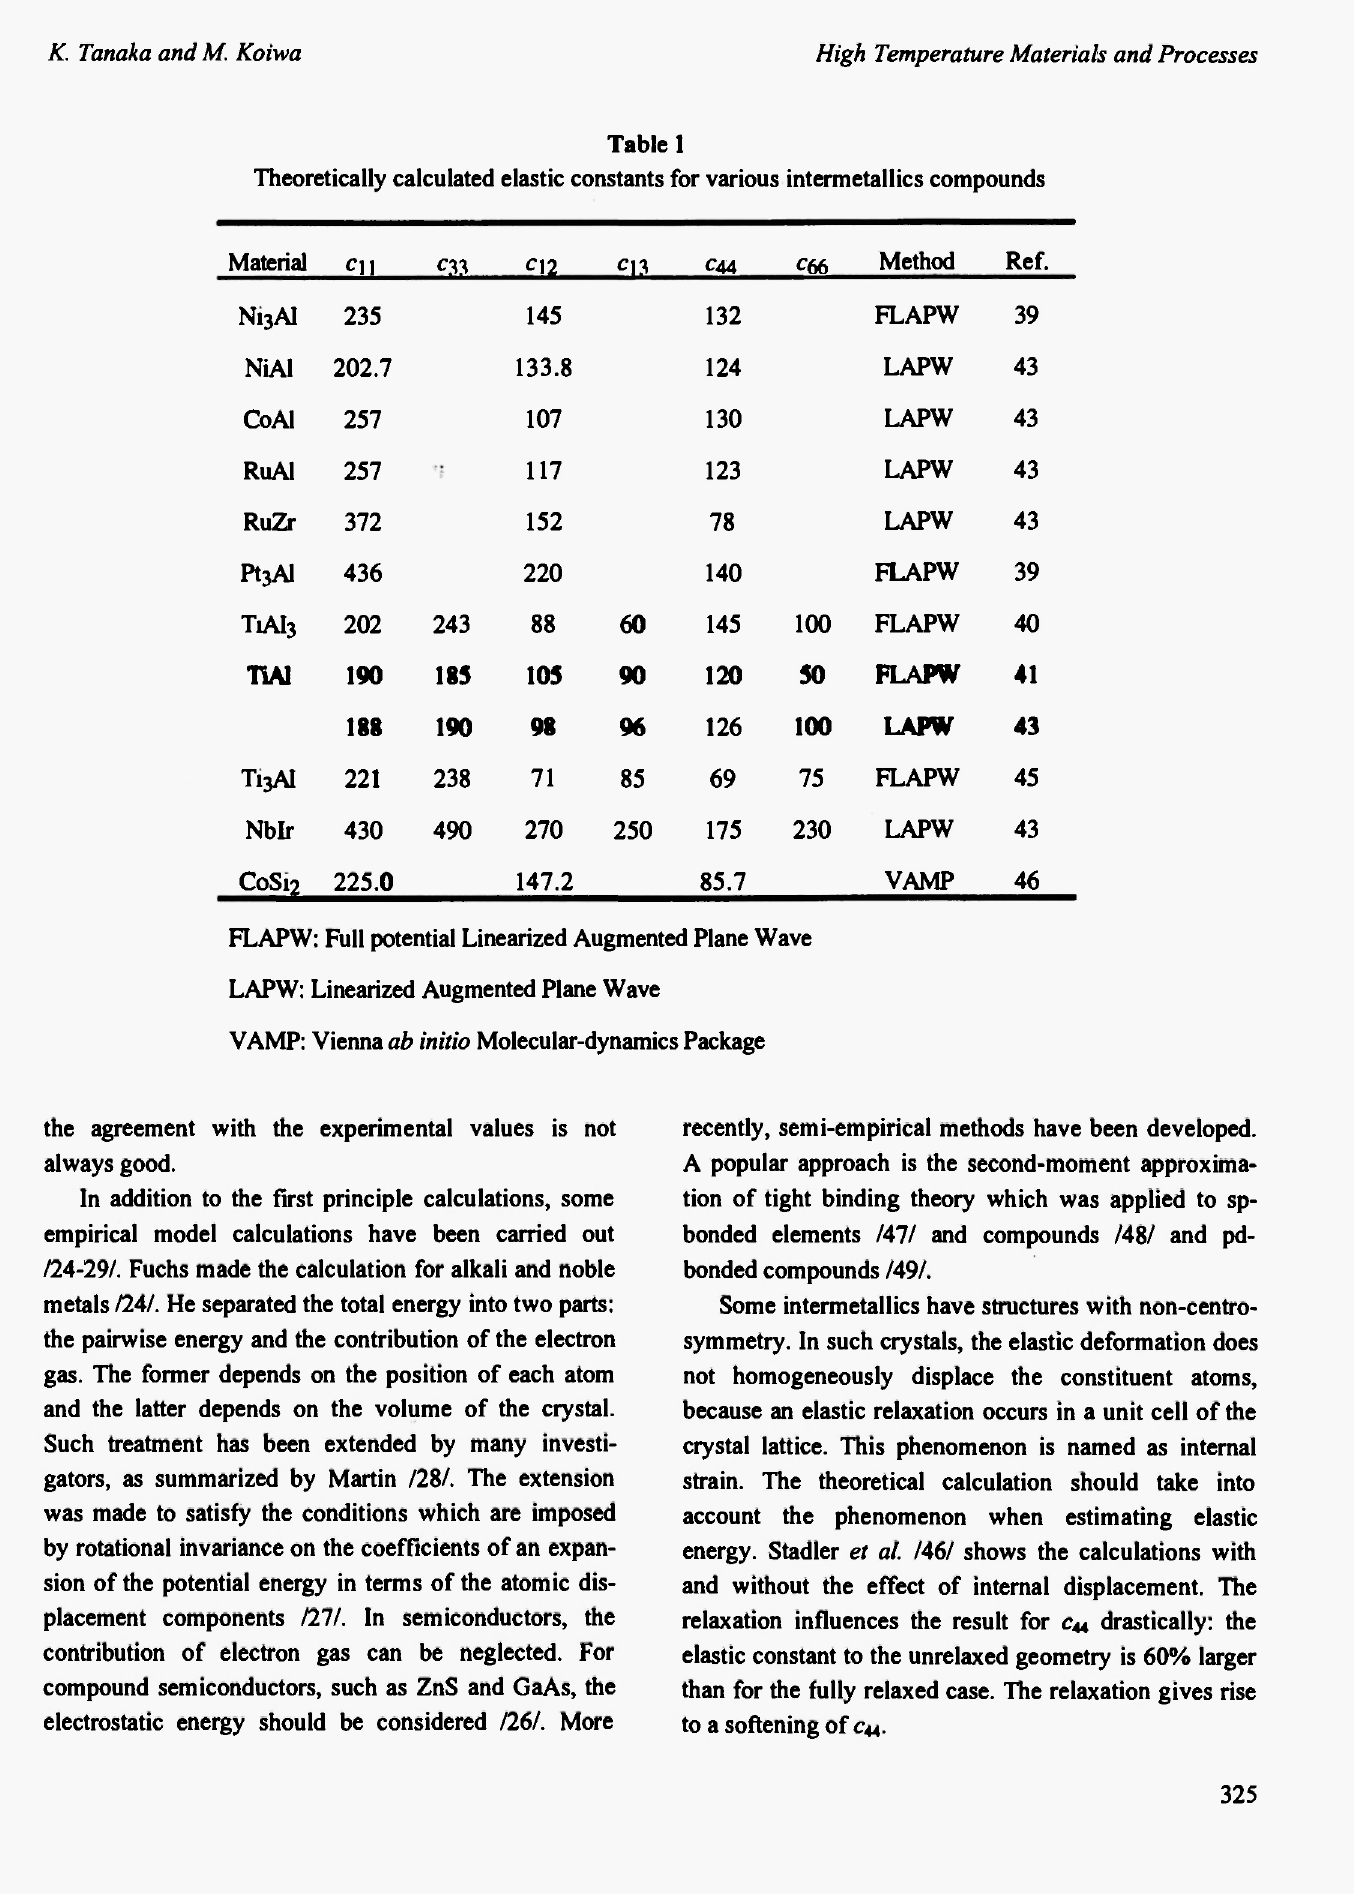
Theoretically calculated elastic constants for various intermetallics compounds